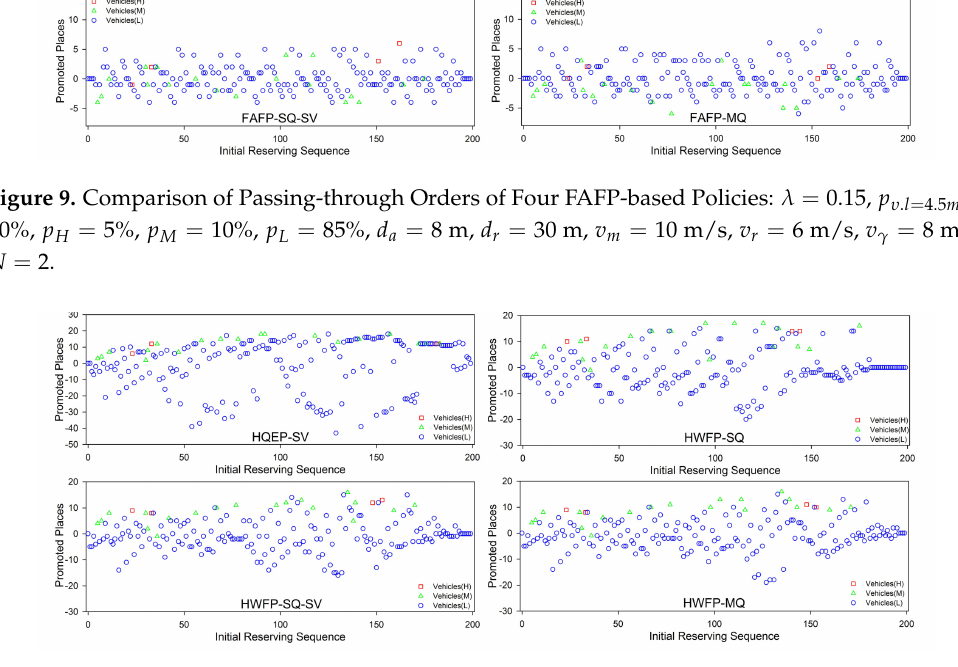
Figure 10. Comparison of Passing-through Orders of Four QoS-oriented Policies: λ = 0.15, p υ . l = 4.5 m = 30%, p H = 5%, p M = 10%, p L = 85%, d a = 8 m, d r = 30 m, v m = 10m/s, v r = 6 m/s, v γ = 8 m/s, N =